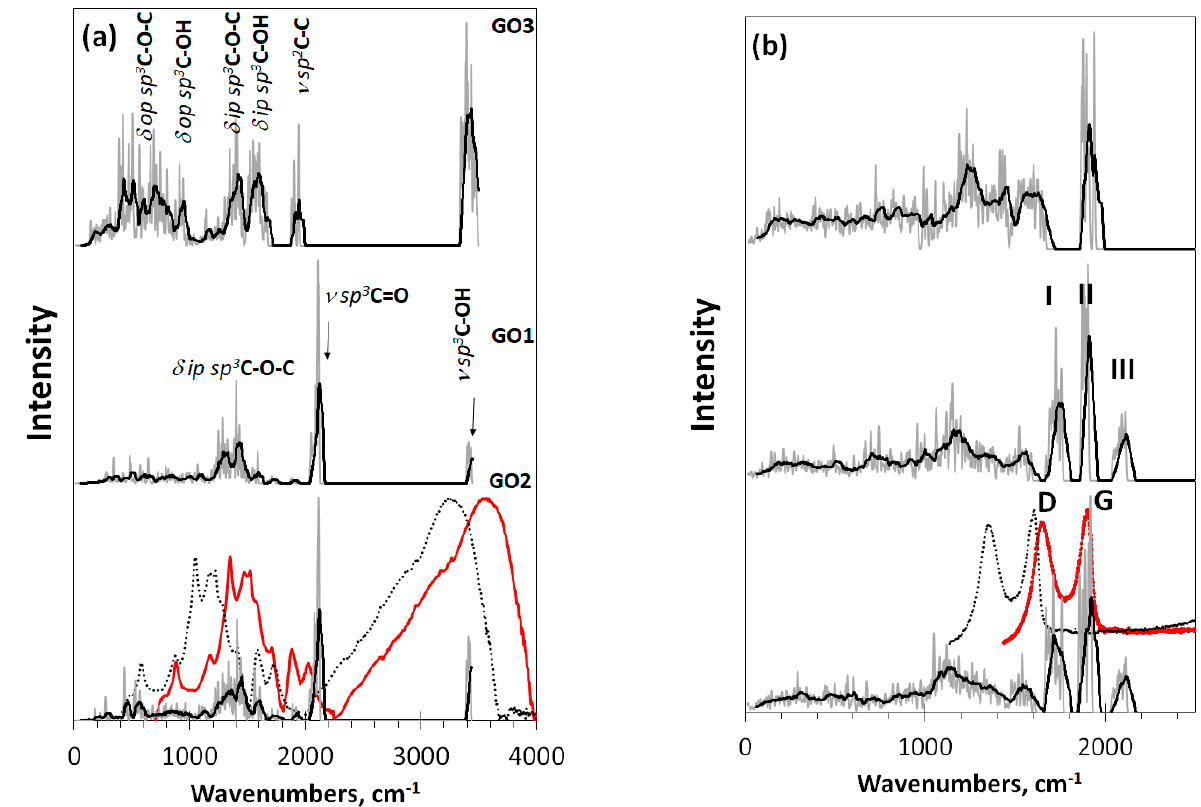
Figure 4. Virtual one-phonon spectra of ( a ) IR absorption and ( b ) Raman scattering of digital twins GO1, GO2, and GO3. Spectra plottings are accompanied by trend lines, corresponding to 50-point linear filtration. RHF AM1 calculations. Dotted and red plottings present original and blue shifted on 300 cm − 1 experimental spectra of GO manufactured by AkKo Lab [54], respectively.